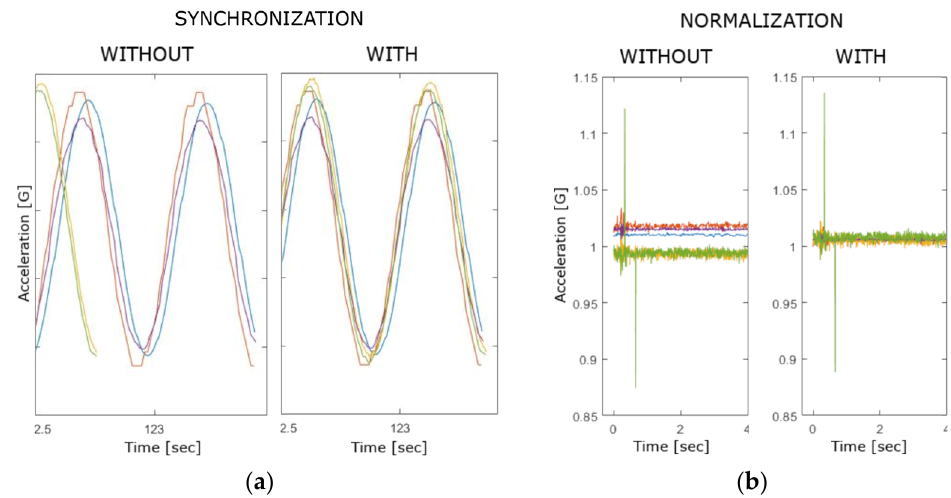
Figure 13. Comparison of raw accelerometer data measured on the x-axis without and with prepro- cessing: ( a ) synchronization and ( b ) normalization.